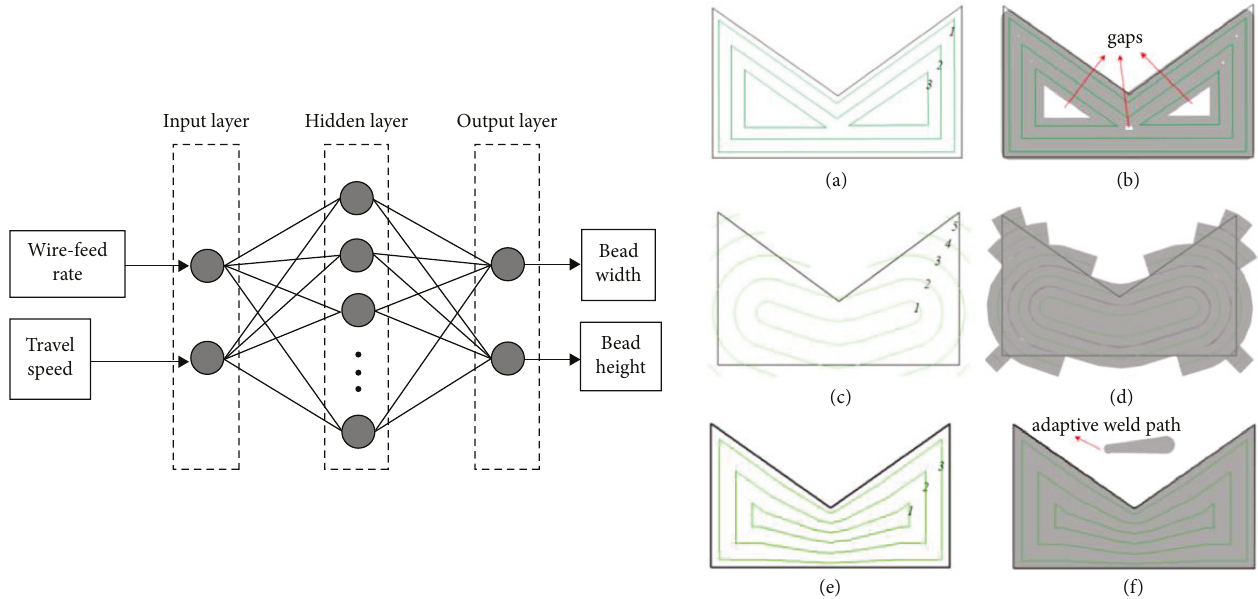
Figure 26: Neural network architecture for predicting bead geometry. Illustrations of different deposition paths. External lines represent the boundaryof the geometry; internallines represent thedeposition paths with the numbersrepresenting the order ofthe deposition paths;grey regions are deposited area by the relevant paths. (a) Contour path patterns; (b) the predicted high accuracy deposition but with internal gaps; (c) MATpath patterns; (d) the predicted void-free deposition but with extra material deposited along the boundary; (e) adaptive MATpath patterns with varying step-over distance; (f) the predicted void-free deposition with high accuracy at the boundary through using adaptive MAT